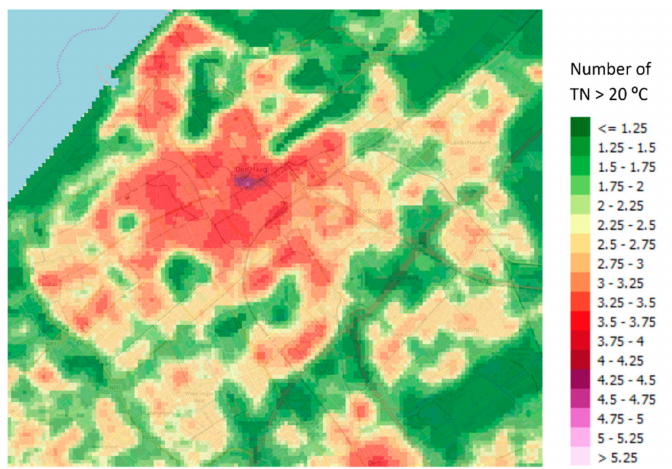
Figure 6. Modeled average number of nights per year above 20 ◦ C for the current climate (2002–2016) for The Hague.